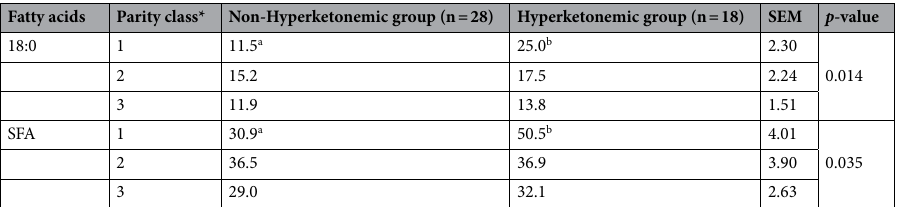
Table 4. Fatty acids (mg/dL) significantly affected by parity class of ewes categorized as non-hyperketonemic group with low BHB or hyperketonemic group with high BHB (BHB > 0.86 mmol/L). *1: primiparous; 2: secondiparous; 3: multiparous. a-b Mean values in the same row which differ